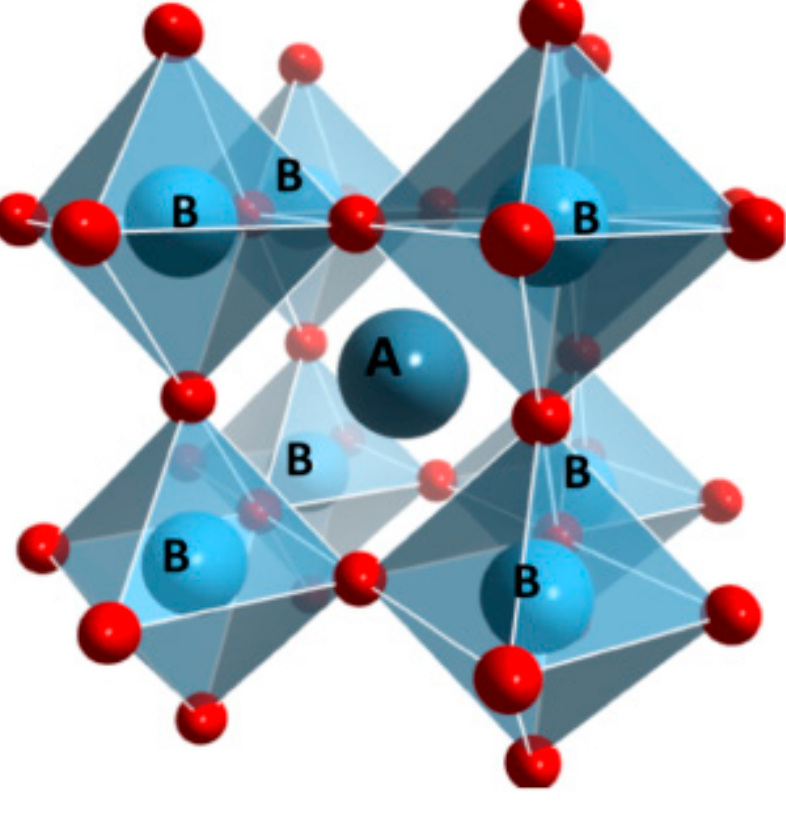
Figure 1. Structure of perovskite [5].